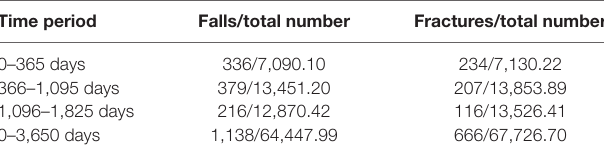
TaBle 6 | Displaying the number of fall and fracture events, over the total number of person years during each time period.